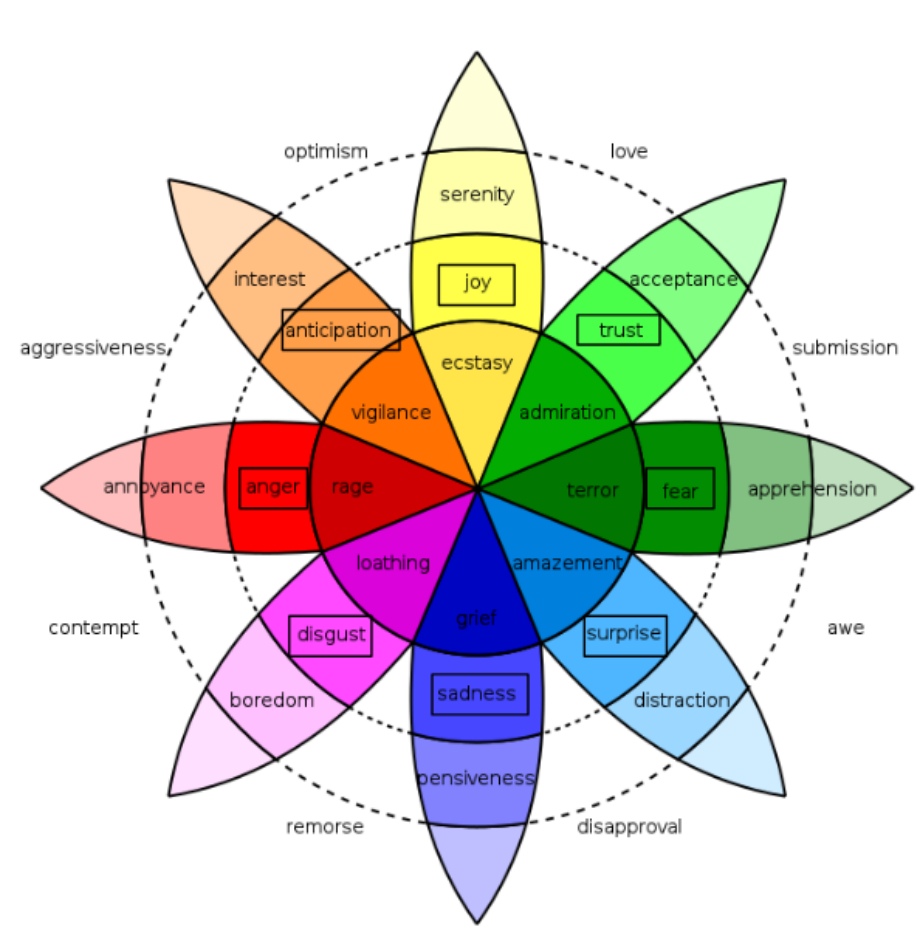
Figure 1. The set of the eight basic emotions proposed by Plutchik